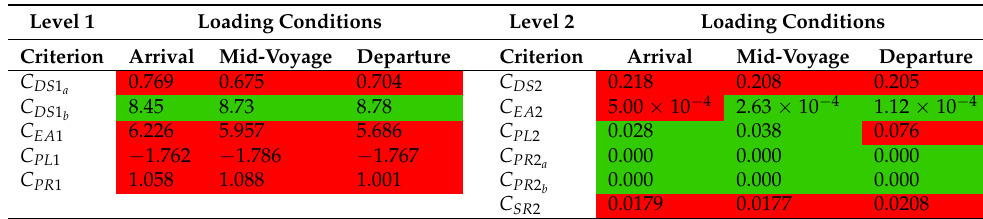
Table 11. Comprehensive assessment of SGISc vulnerability levels for Y02 considering the central Mediterranean Sea. Criteria compliant with the standard are highlighted in green. Criteria not compliant with the standard are highlighted in